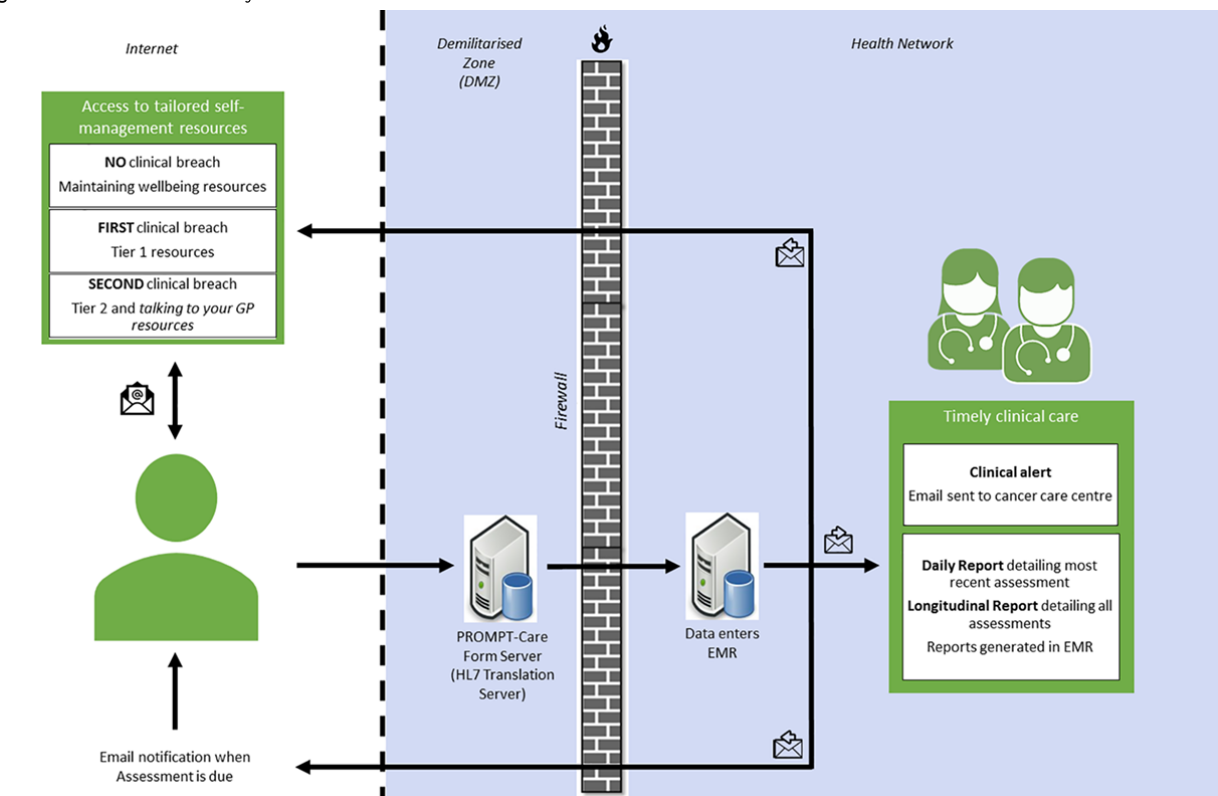
Figure 1. PROMPT-Care 2.0 system